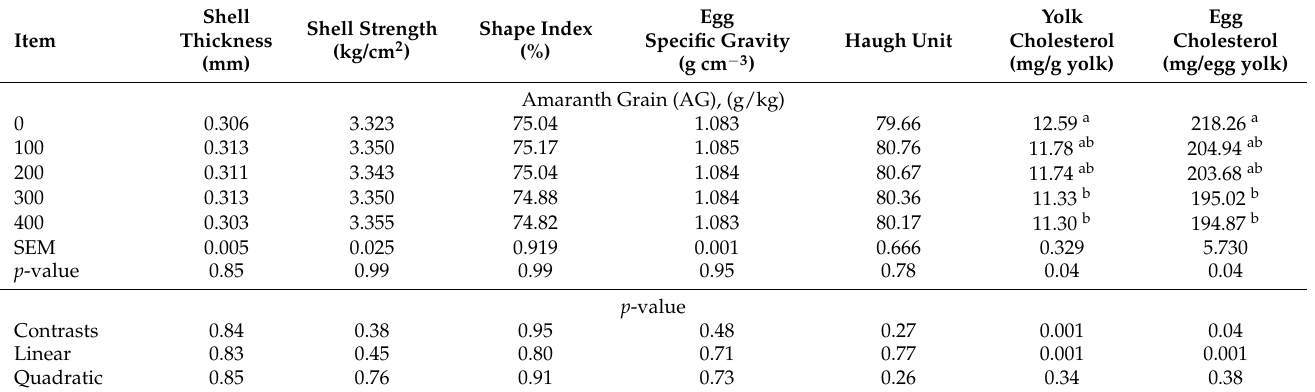
Table 4. Main effects of amaranth feeding, enzyme additionand interaction between amaranth feeding and enzyme addition on egg quality traits of laying